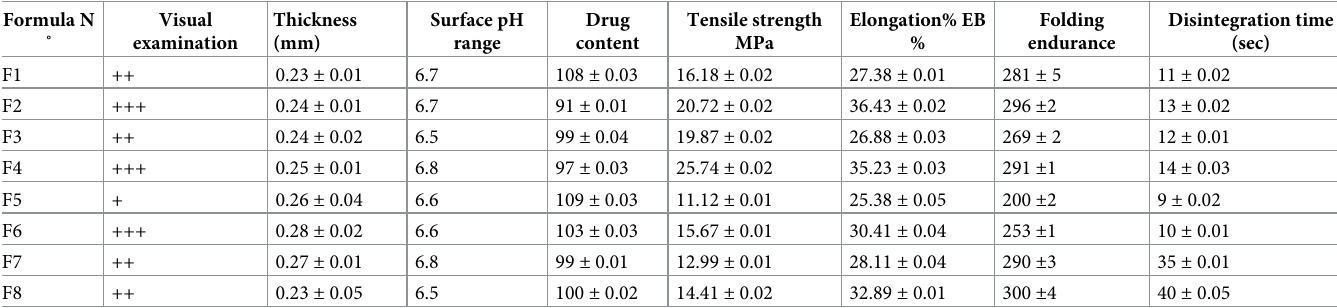
Table 2. In vitro evaluation of medicated fast dissolving films